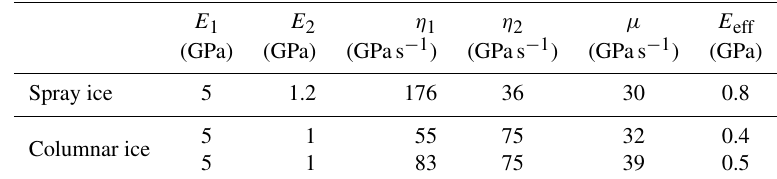
Table B1. Rheological coefficients of spray sea ice and columnar sea ice.